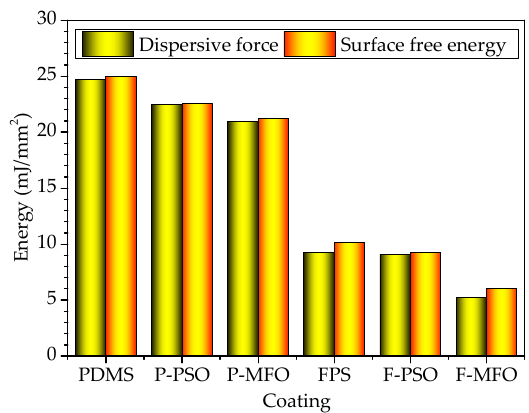
Figure 6. Surface energy and dispersive force of studied coatings.